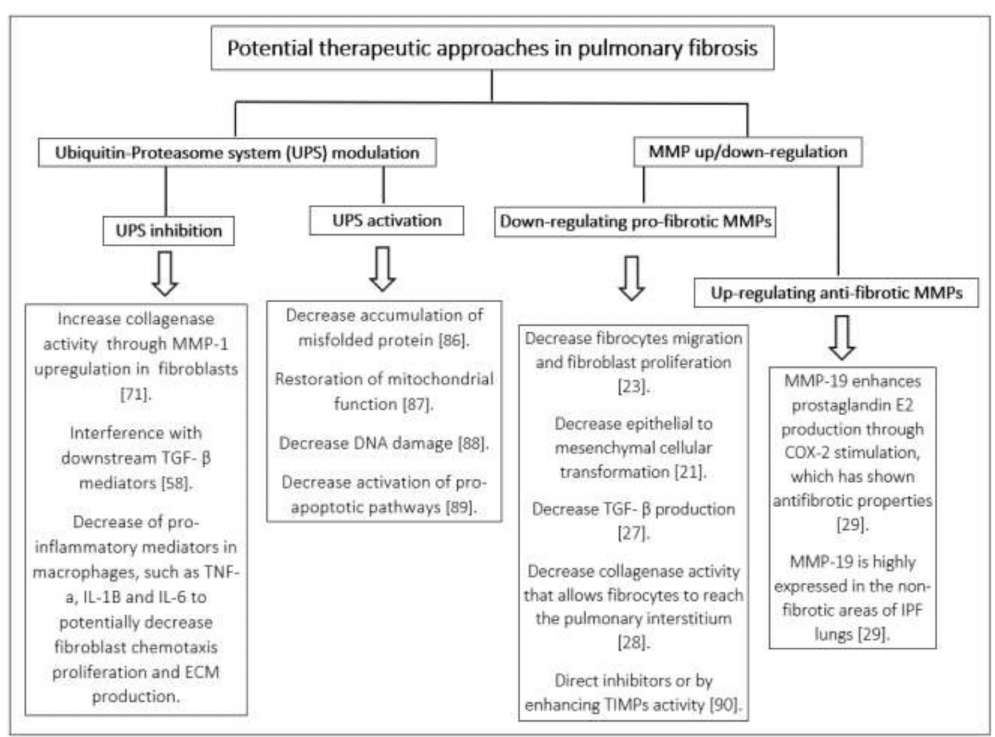
Figure 2. Potential therapeutic approaches in pulmonary fibrosis involving the ubiquitin-proteasome system (UPS) and metalloproteinases (MMPs) modulation. COX: cyclooxygenase, IL: interleukin, TGF- β : tumor growth factor β , TIMPs: tissue inhibitors of metalloproteinases, TNF: tumor necrosis factor, IPF: idiopathic pulmonary